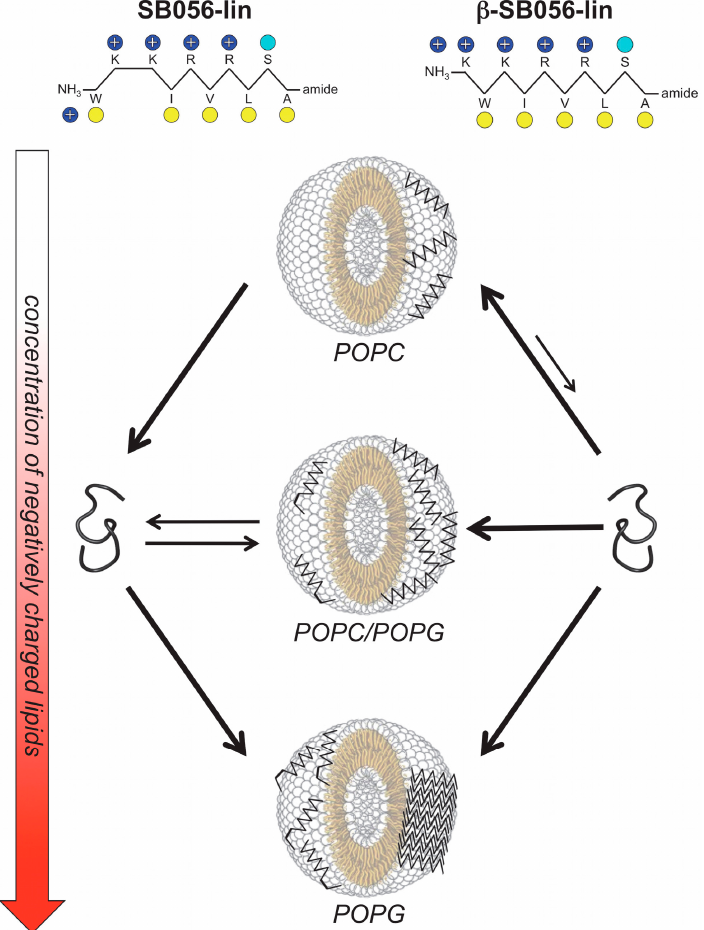
Figure 3. Summary of SB056 peptide-lipid interactions. The proportion of anionic lipids in the vesicles is increased from top to bottom (as indicated by the red arrow). The behaviour of the original monomeric, linear peptide SB056-lin, is represented on the left-hand side and the sequence-optimized β SB056-lin on the right. Black arrows of different lengths and thicknesses are used to indicate the different binding equilibria. SB056-lin binds only to anionic bilayers, and in a not-so-well-ordered β -stranded conformation. The sequence optimized β SB056-lin, on the other hand, binds even to zwitterionic bilayers and forms regular β -strands that self-assemble into extended β -sheets when the negative charge of the bilayer exceeds the electro-neutrality of the peptide-lipid system. POPC: 1-palmitoyl-2-oleoyl- sn -glycero-3-phosphocholine; POPG: 1-palmitoyl-2-oleoyl- sn -glycero-3-phospho-(1 ′ -rac-glycerol). From [31]. Reproduced with permission.